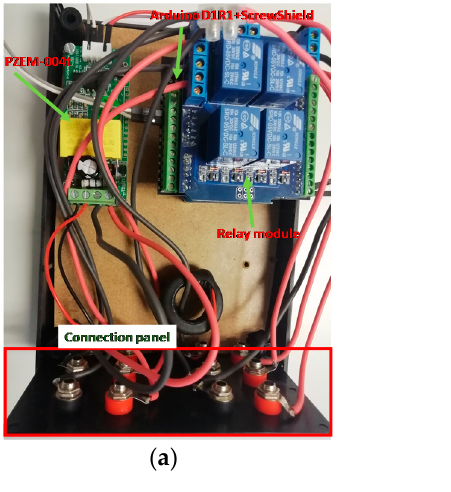
Figure 6. PFCMS: ( a ) Internal connections; ( b ) Final prototype.